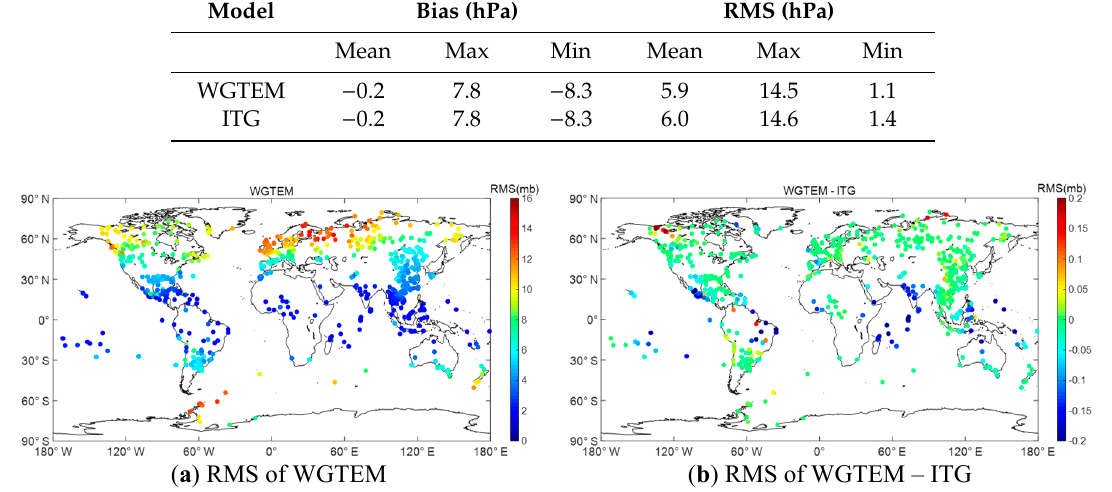
Figure 7. Air pressure RMS from WGTEM at each station, and comparison with RMS from ITG model, validated by NOAA data.